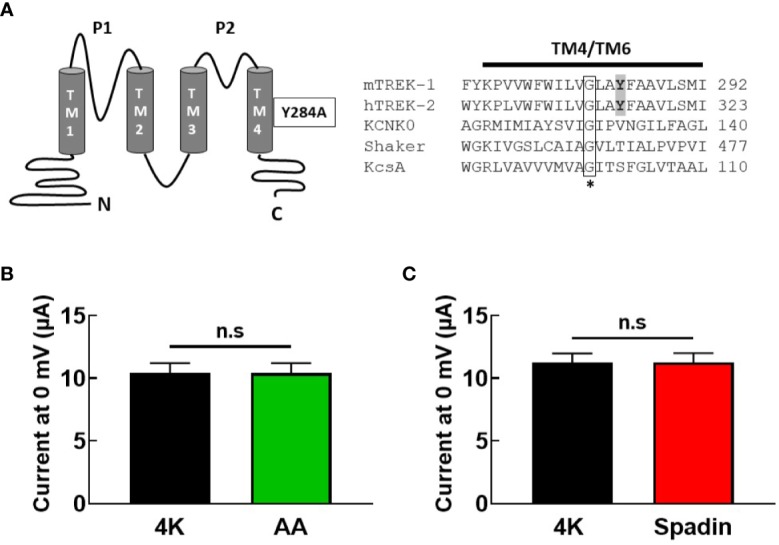
Gating mutation in TM4 reveals spadin is unable to inhibit hyper-active mTREK-1 channels. (A)
left panel, structural diagram of mTREK-1 showing position of Y284A gating mutation, right panel, sequence alignment of distal pore-lining transmembrane domains (TM4) of mTREK-1 (NP_034737), hTREK-2 (NP_612191), KCNK0 (AAC69250), (TM6) Shaker (CAA29917), and (TM2) KcsA (POA333.1). Highlighted in bold are the tyrosine residue of mTREK-1 (Y284) and the analogous tyrosine in hTREK-2 (Y315). Mutation of Y315 to alanine significantly reduces norfluoxetine activity in human TREK-2 (Mcclenaghan et al., 2016). * Conserved glycine hinge residue (boxed). Mutation to this residue is known to promote stabilization of the open state across the potassium channels listed. (B, C) Mean bar graphs of chimera channel currents recorded at 0 mV by TEVC in control bath conditions (4K, black), and following treatment with (B) 10 uM AA (n = 9, green) or (C) 1 μM spadin (n = 7, red). Data are presented as mean ± SEM. p >0.05, not significant (n.s).